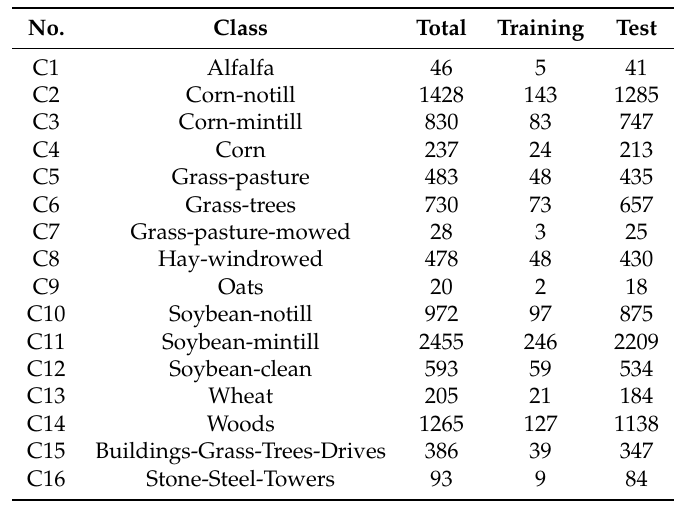
Table 1. Number of pixels for training/testing and the total number of pixels for each class in the Indian Pines ground truth map.